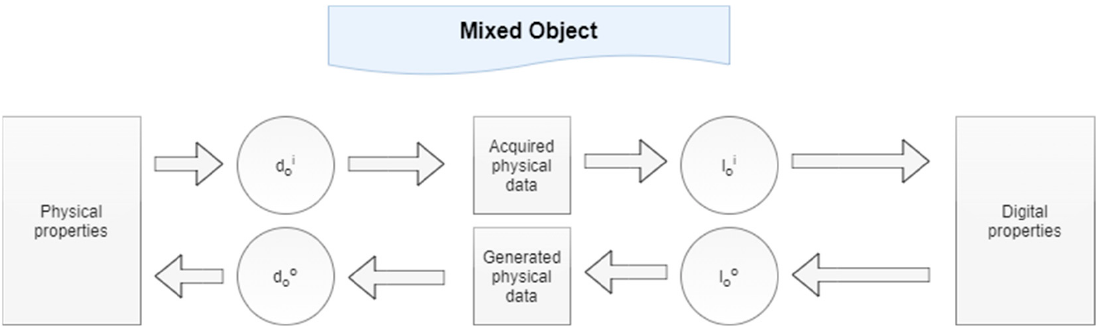
Figure 4. Mixed Object, as a result of the linkage between physical and digital properties.